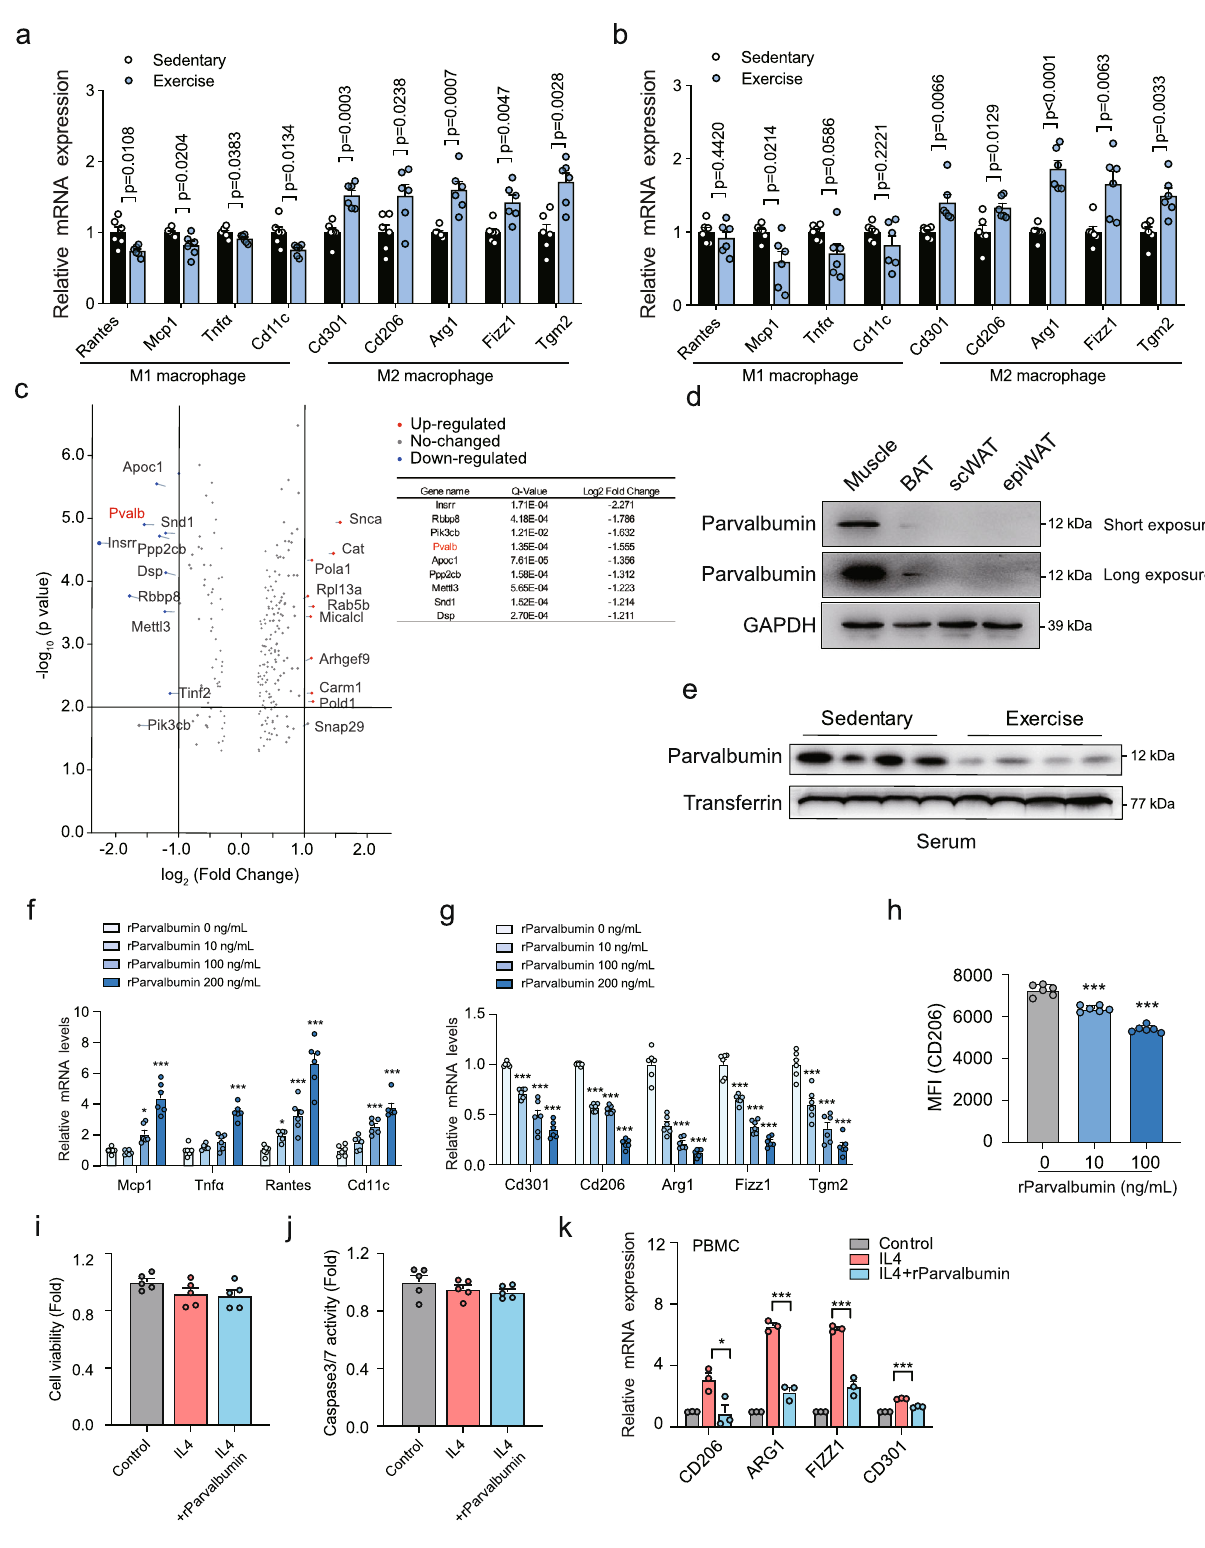
Circulating parvalbumin suppresses M2 macrophage polar- ization . To identify the circulating parvalbumin function, we used the male parvalbumin knockout (KO) mice as a discovery tool. We fi rst examined parvalbumin expression in muscles and serum of KO and WT mice using western blot (Fig. 2a). Next, we use parvalbumin KO mice to further address the role of